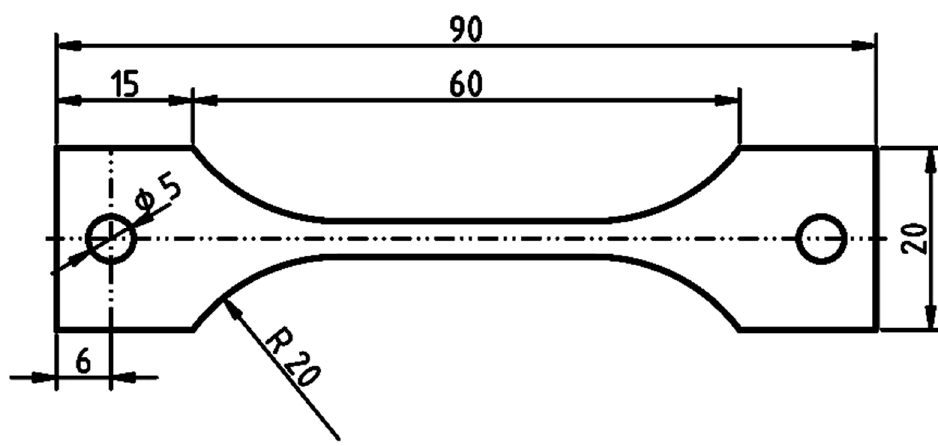
Figure 2. Geometry of tensile specimens; dimensions in mm.